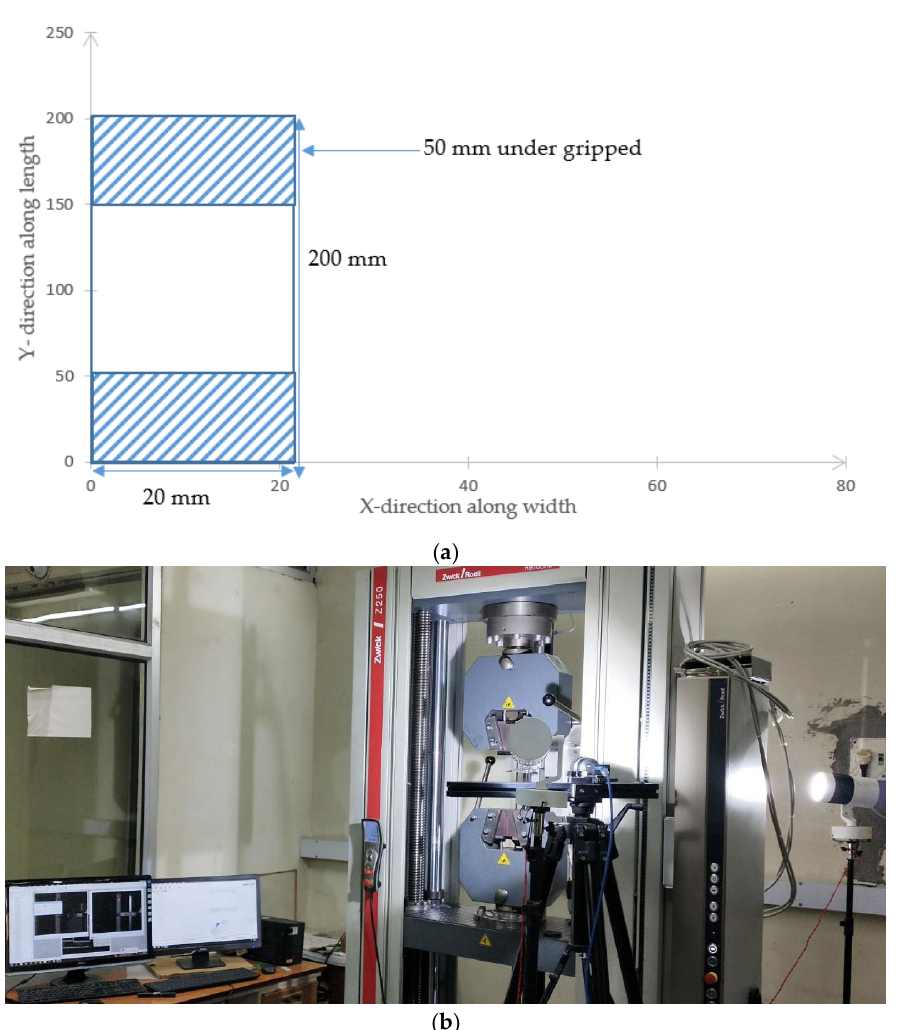
Figure 2. ( a ) Test specimen with dimensions and a coordinate frame. ( b ) Experimental setup for the tension test with the DIC devices.